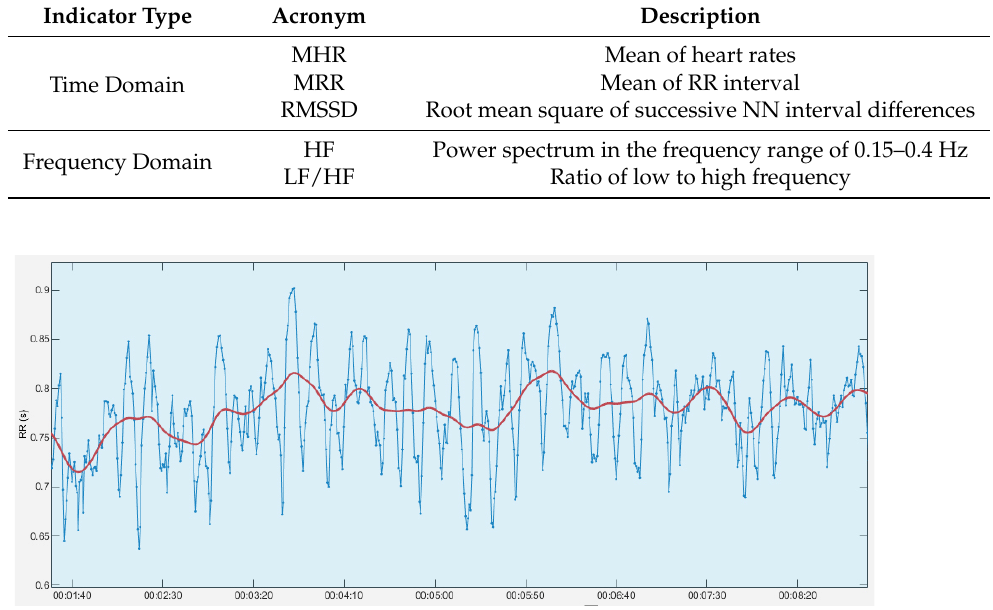
Figure 5. Partial RR